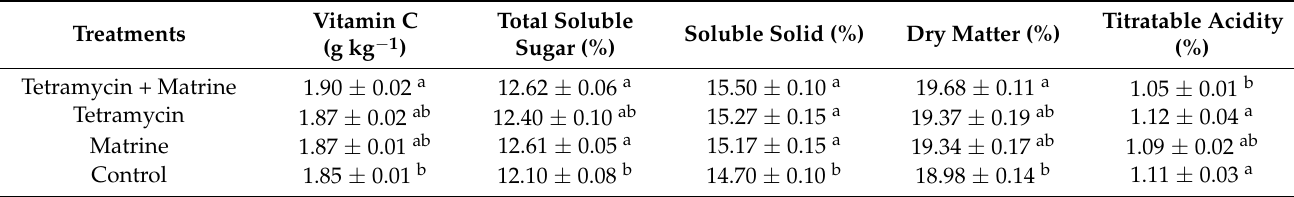
Table 6. The effects of tetramycin and matrine on quality of kiwifruit. Table 5. The effects of tetramycin and matrine on the development of kiwifruit.